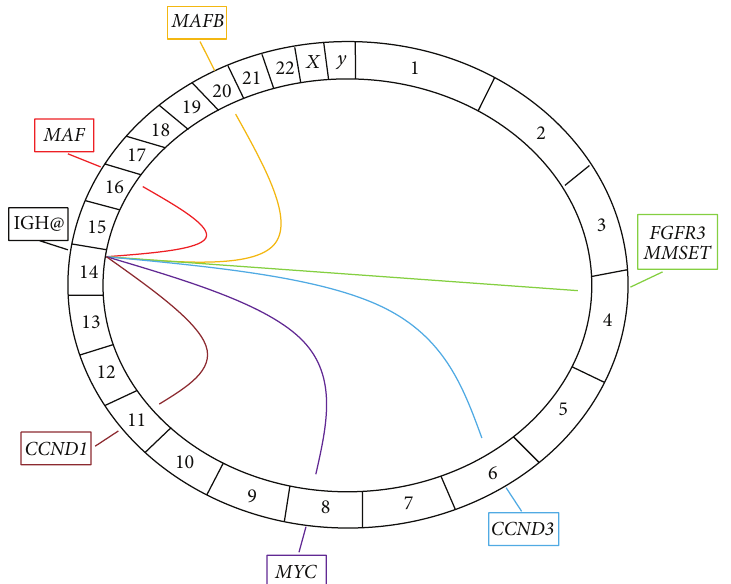
Figure 3: The key chromosomal translocations in myeloma . A Circos plot, with the chromosomes arranged in a clockwise direction, demon- strating the key translocations in myeloma. The translocations are represented as lines emerging from the immunoglobulin heavy chain (IGH@) locus on chromosome 14 to their respective partner chromosomes. The genes involved in each translocation are represented in boxes outside the plot. All translocations represent primary events except 𝑡(8;14) involving MYC which is a secondary